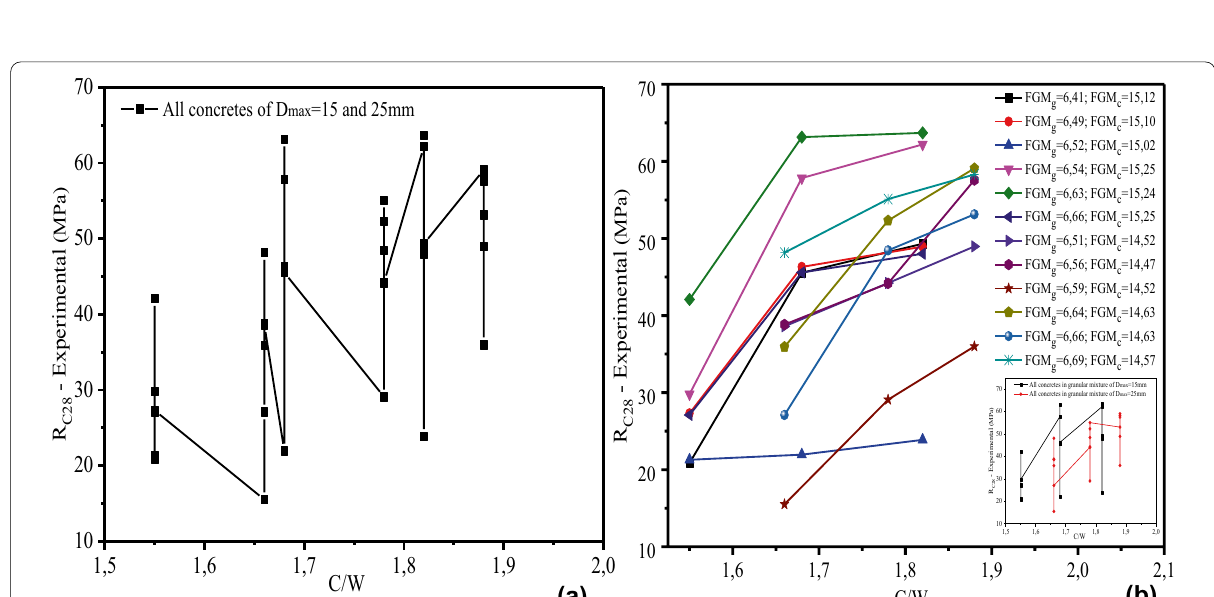
Fig. 18 Mechanical strength R C28 as a function of the ratio C / W for concretes D 15 and D 25 . a Results for all types of concrete, b results obtained according to FGM g and FGM C